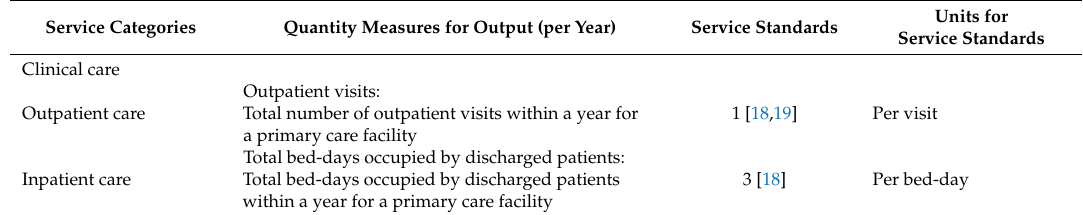
Table 2. Service standards for clinical care and public health